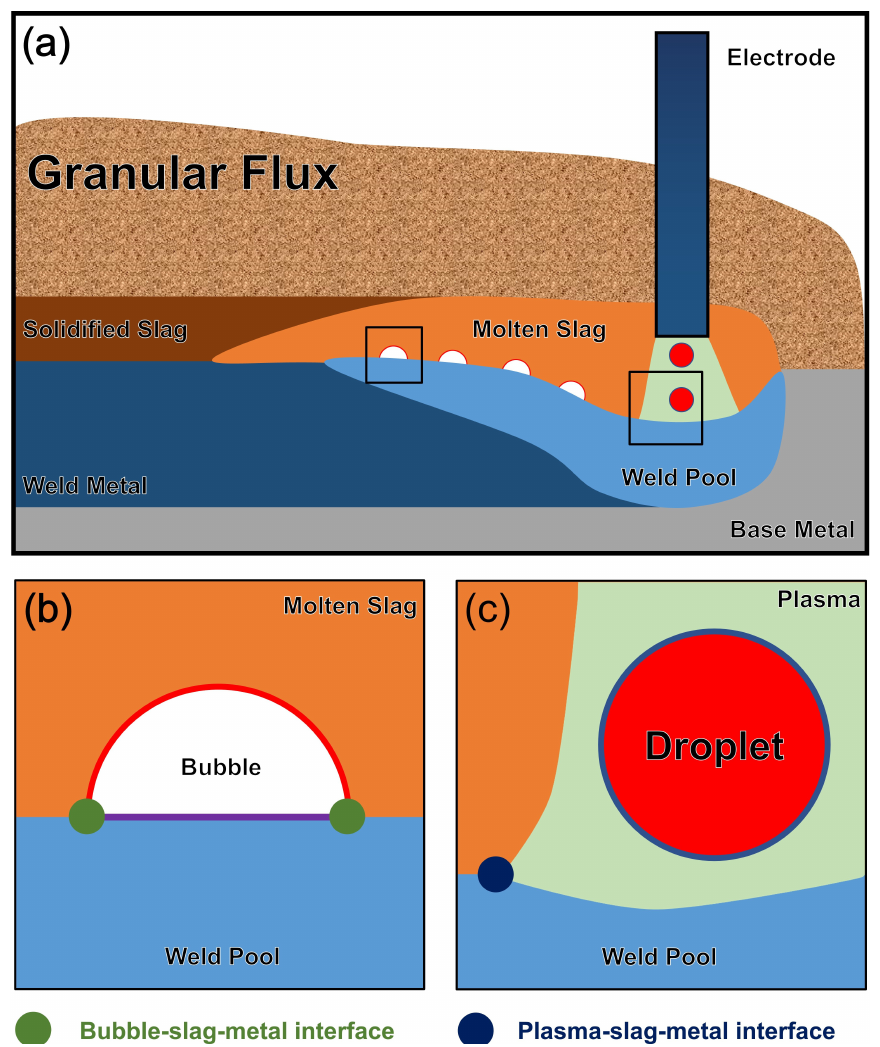
Figure 1. Major phases and reaction interfaces associated with gas phases in SAW: ( a ) Schematic diagram of SAW, ( b ) Plasma-associated reaction interfaces, ( c ) Bubble-associated reaction